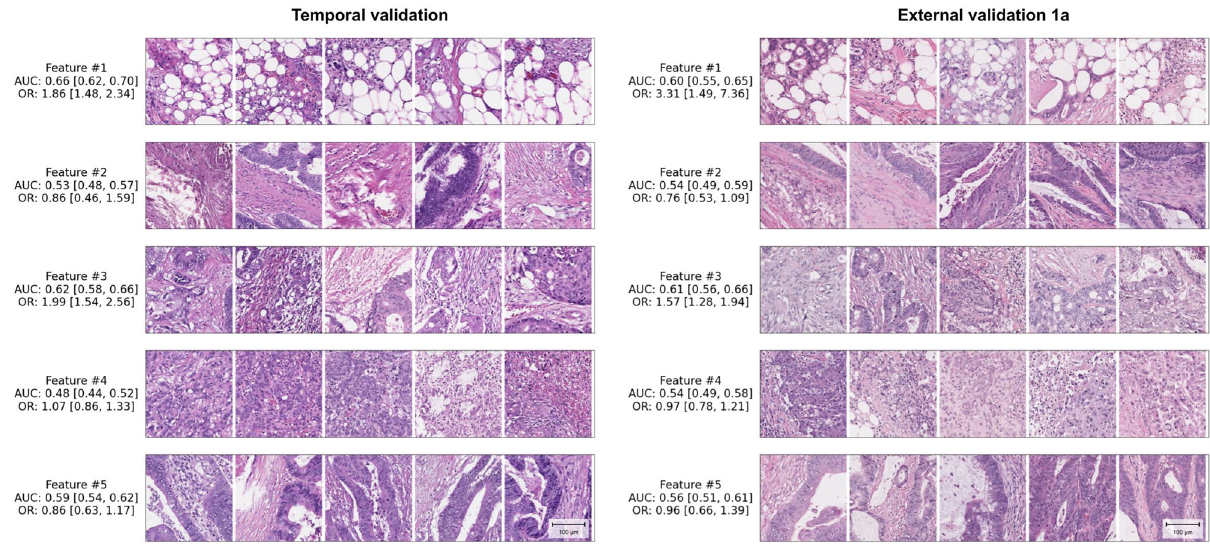
Fig. 2 Representative patches of machine-learned features associated with lymph node metastasis. Univariable AUROCs, univariable odds ratios (OR) and sample patches for the top 5 machine-learned features are shown. Patches representing the same machine-learned features are shown for the temporal validation set and the external validation set 1a, respectively. Patches selected here are closest to each cluster centroid, and each patch within a single feature is sampled from a unique case. Patches are 289 × 289 pixels obtained at 10X, with scale bar in lower right showing length of 100 micrometers. Table 1 Signi fi cance of adding machine-learned features to baseline clinicopathologic